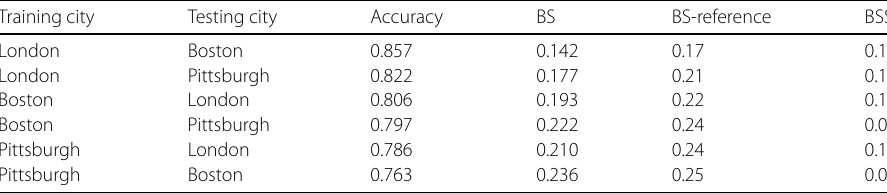
Table 6 Accuracy and Brier score for out-of- city evaluations Training city Testing city Accuracy BS BS-reference BSS London Boston 0.857 0.142 0.17 0.16 London Pittsburgh 0.822 0.177 0.21 0.16 Boston London 0.806 0.193 0.22 Pittsburgh